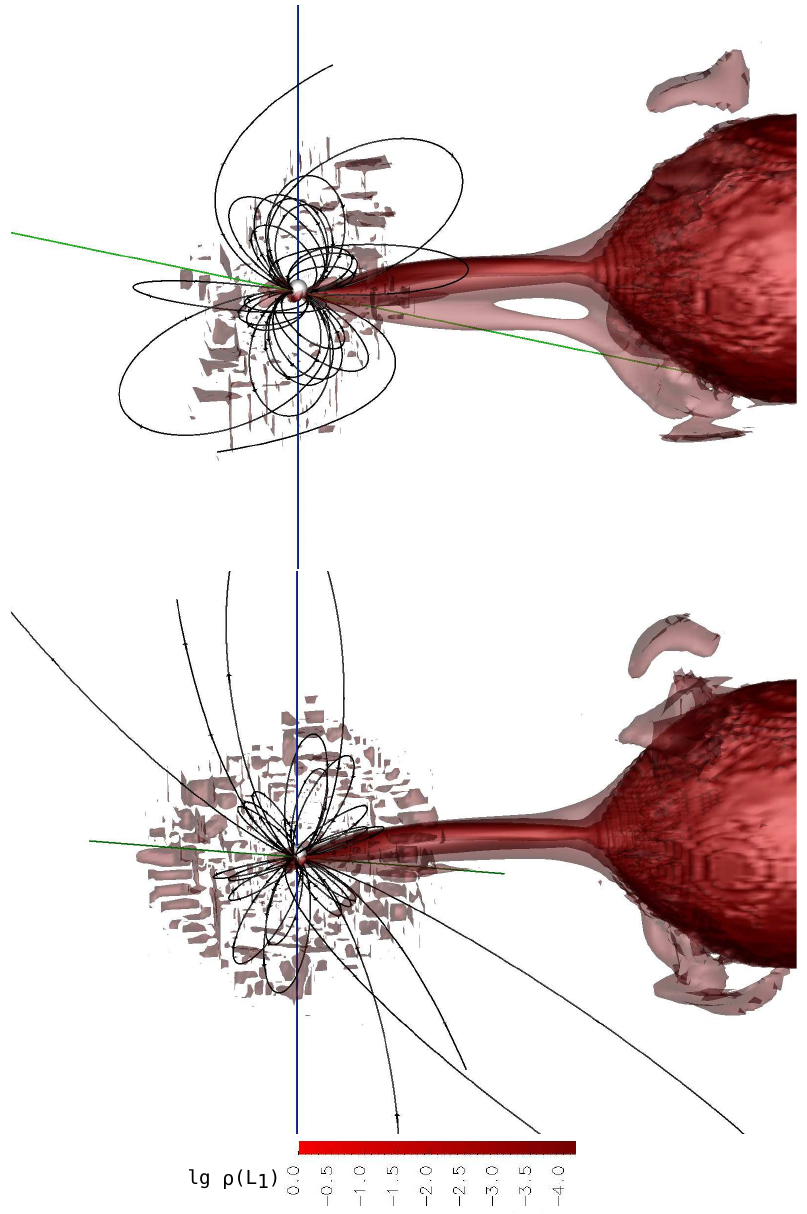
Figure 10. The same as Figure 6 but for phases 0.8 ( upper panel) and 0.9 ( lower panel). The system is shown from the point of view of an Earth observer at the orbital phase